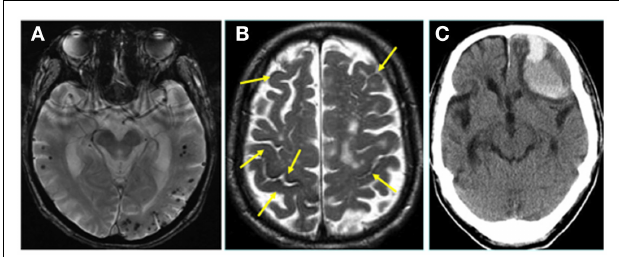
FIGURE 4 | (A) Cerebral microhemorrhages with lobar distribution in a patient with Alzheimer’s disease (AD) on gradient-echoT2* imaging. (B,C) A patient with AD had presented with multiple, old focal subarachnoid hemorrhages (superficial siderosis; arrows) onT2-weighted MRI at the time of the diagnosis of AD (B) .The patient later developed a large intracerebral hemorrhage in the left frontal lobe as shown on CT (C) , probably related to CAA (by courtesy of Dr.Toshiya Fukui, Showa